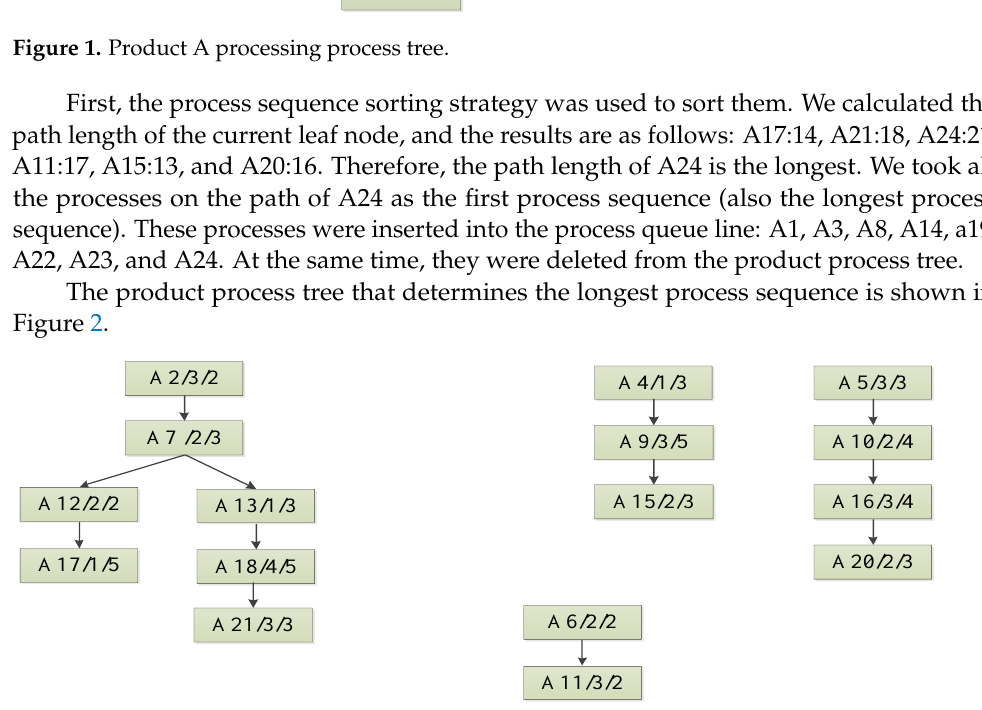
Figure 2. The product process tree becomes a forest when the first process sequence is determined.